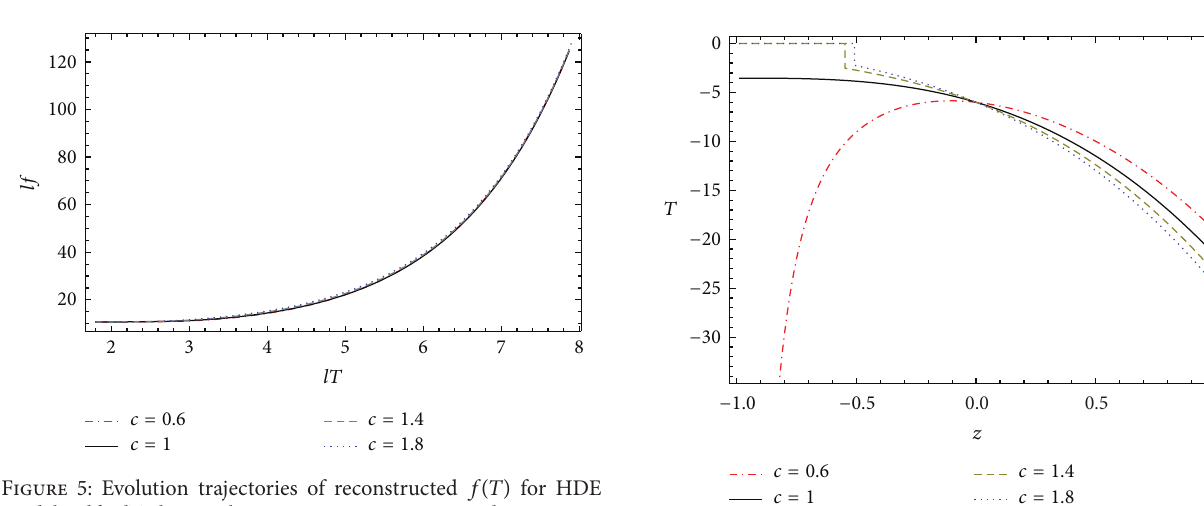
Figure 5: Evolution trajectories of reconstructed 𝑓(𝑇) for HDE model in 𝑙𝑓−𝑙𝑇 plane with Ω 𝑚0 = 0.315 , 𝐻 0 = 67.3 , and 0 ⩽ 𝑧 ⩽ 10 . (19) can be solved numerically with boundary condition (13) and Ω 𝜗 = 1 − Ω 𝑚 . Here, we set 𝑐 = 0.6, 1, 1.4, 1.8 , Ω 𝑚0 = 0.315 and plot the reconstructed function 𝑓(𝑇) on 𝑙𝑓 − 𝑙𝑇 plane in Figure 5, where 𝑙𝑓 = ln (−𝑓) and 𝑙𝑇 = ln (−𝑇) . It is clear that different values of 𝑐 do not affect the shape of the curves and their evolution is quite similar in these plots.